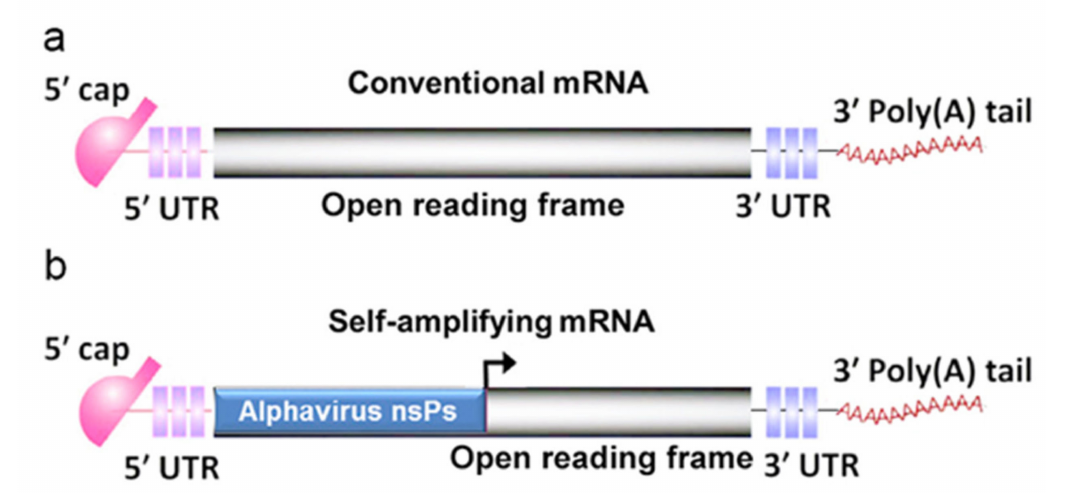
Figure 2. Key structures of in vitro transcribed mRNA (IVT mRNA). ( a ) Conventional mRNA is composed of a 5 (cid:48) cap, a 5 (cid:48) untranslated region (UTR), an open reading frame (ORF), a 3 (cid:48) UTR, and a 3 (cid:48) poly(A) tail. ( b ) Self-amplifying mRNA includes a 5 (cid:48) cap, a 5 (cid:48) UTR, an ORF, a 3 (cid:48) UTR, a 3 (cid:48) poly(A) tail, and an additional alphavirus sequence encoding nonstructural proteins